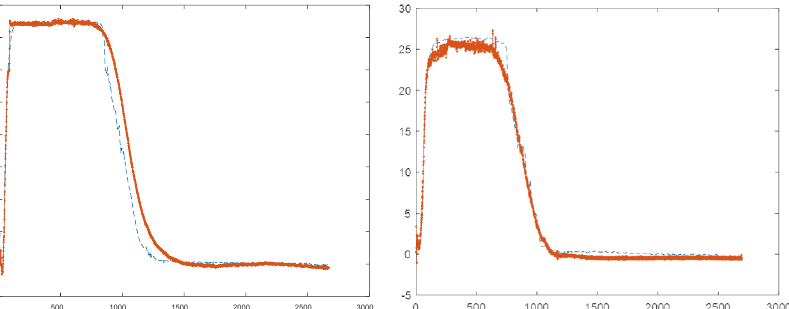
Figure 3. Outcome of the prediction − best ( left ) and worst ( right ) predictions for hydration (Number of data on the x -axis, ∆ T on the y -axis).